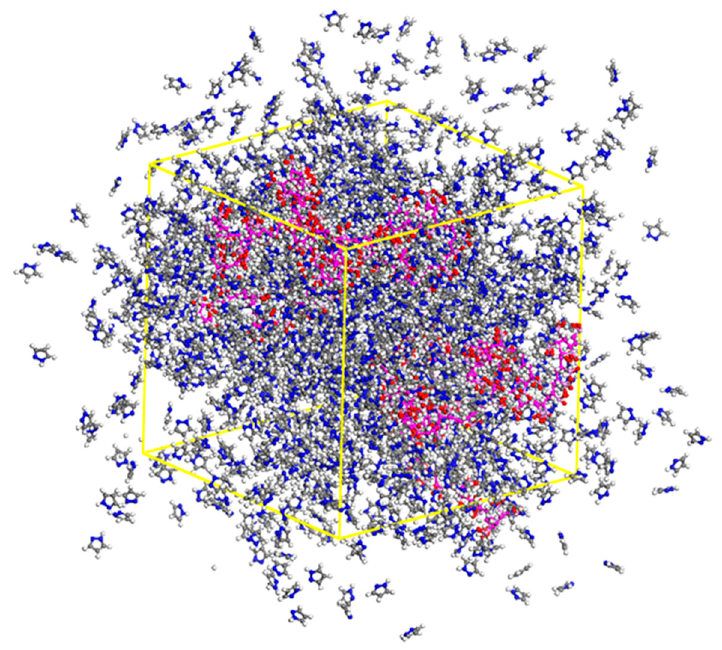
Figure 2. The simulation cell of mixing poly(vinyl phosphonate anion), pyrazole (Py) and proton.